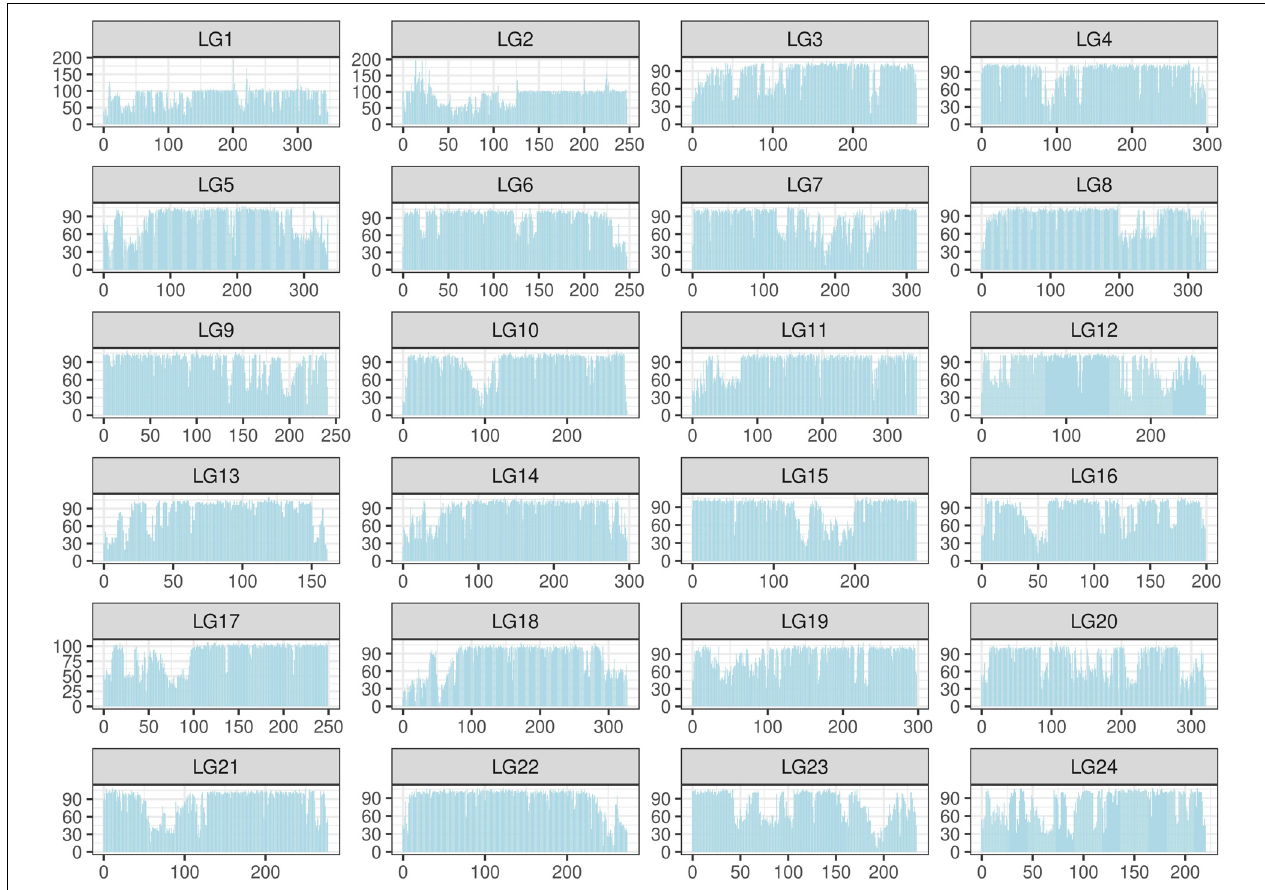
FIGURE 3 | Distribution of single-nucleotide polymorphism (SNP) in the large yellow croaker genome. The distribution was calculated in 24 linkage groups by a unit (bin) of 100K base pairs. The X -axis represents the location in each linkage group; the Y -axis represents the number of